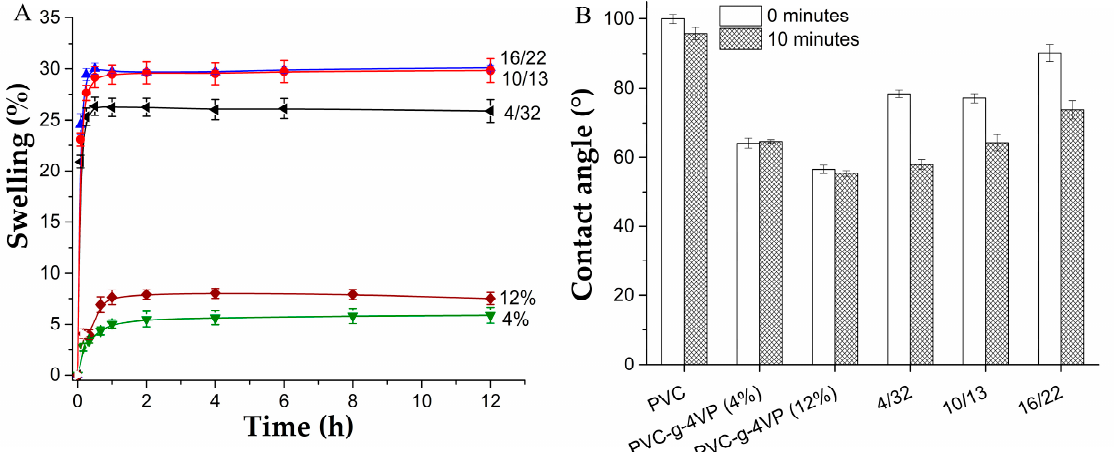
Figure 5. ( A ) Swelling curves in water at 25°C, reported: mean ± standard error of the mean, n = 3. and ( B ) Water contact angle, reported: mean ± standard error of the mean, n = 6. PVC- g - 4VP 4% /4VPSS 32% (4/32), PVC- g -4VP 10% /4VPSS 13% (10/13), and PVC- g -4VP 16% /4VPSS 22% (16/22).